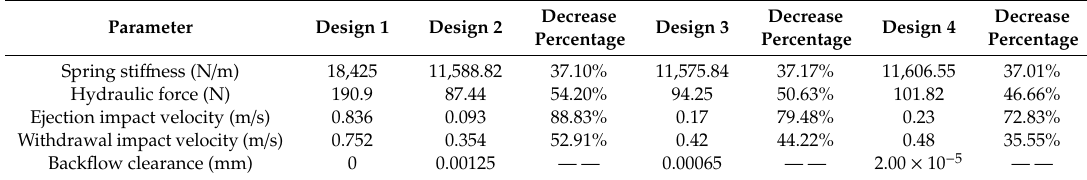
Table 6. The comparison of di ff erent